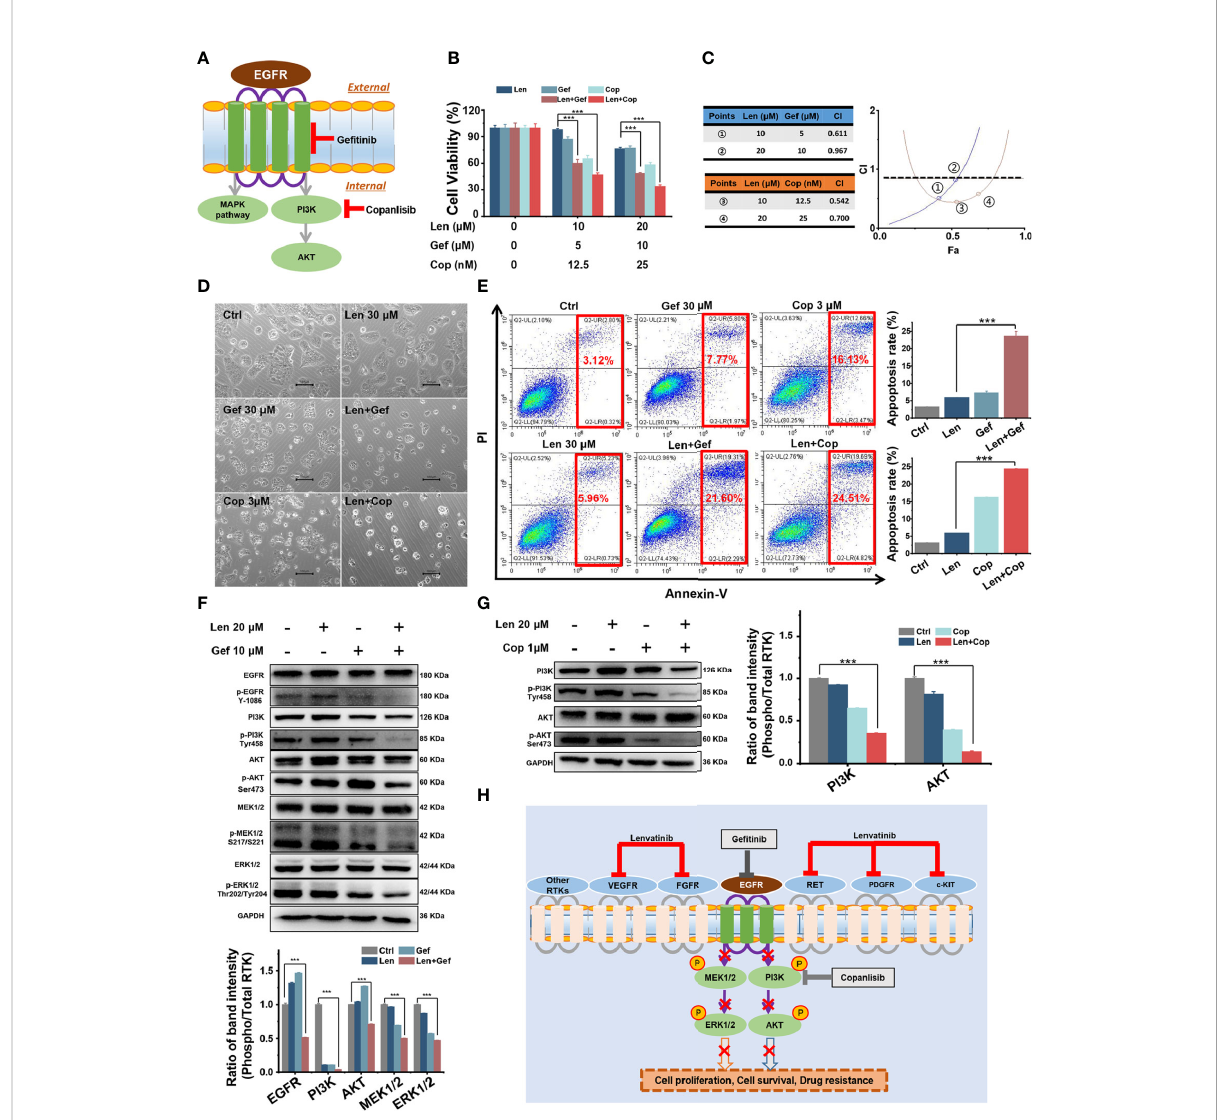
FIGURE 5 In vitro combined antitumour effect of lenvatinib and ge fi tinib or copanlisib. (A) Schematic diagram indicates that ge fi tinib and copanlisib targeted EGFR and PI3K, respectively. (B, C) The MTT results and CI plots con fi rmed that combined treatments synergistically inhibited cell viability. (D, E) The addition of ge fi tinib or copanlisib enhanced cell apoptosis, as shown in micrographs and fl ow cytometry plots. (F, G) The EGFR pathway was signi fi cantly inhibited by the addition of ge fi tinib, and the PI3K/AKT pathway was signi fi cantly inhibited by the addition of copanlisib. (H) Schematic diagram delineates the proposed mechanism of overcoming LR in HCC by targeting the EGFR/PI3K pathway. *** p <